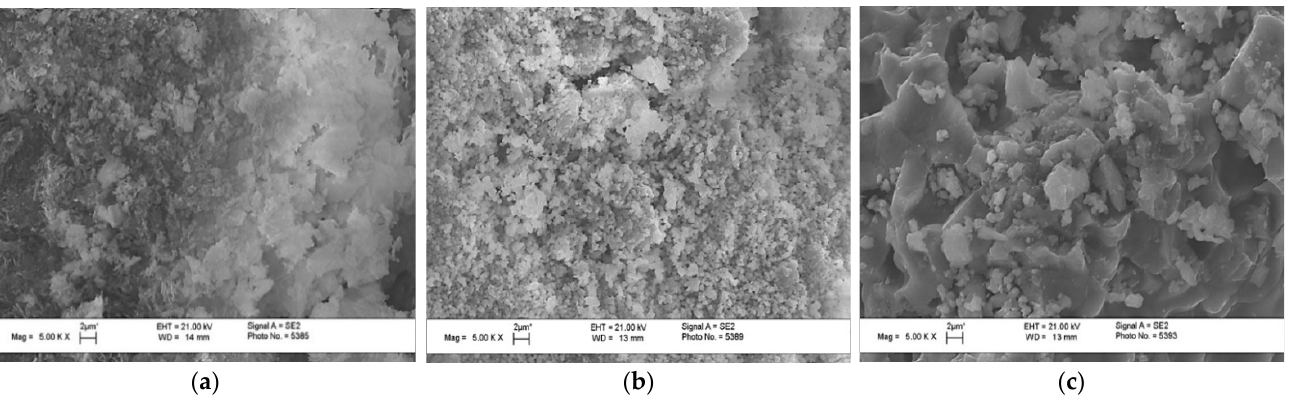
Figure 7. Relative density of ceramic samples, obtained via annealing of cement-salt stone in the temperature range of 500–900 °C.